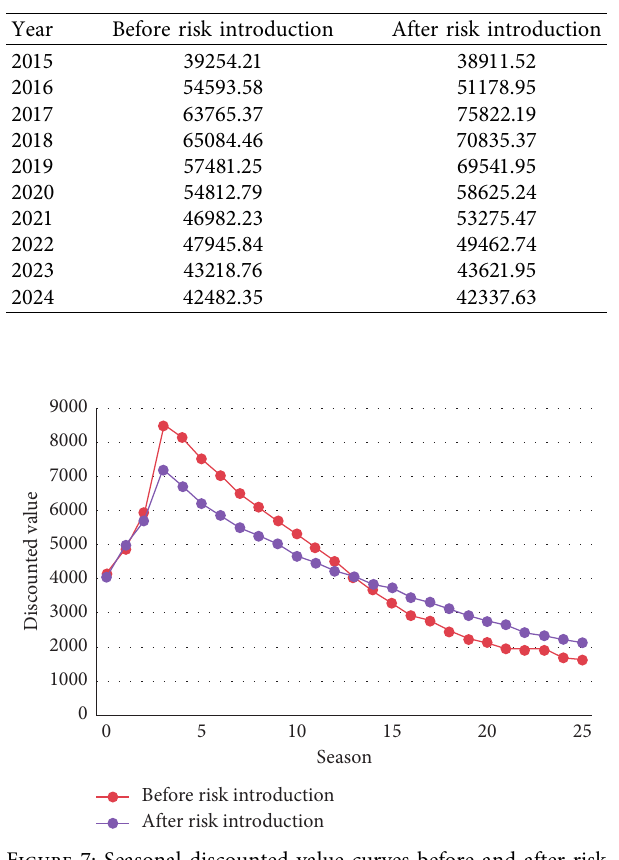
Table 4: Discounted values before and after risk introduction in 2015–2024.